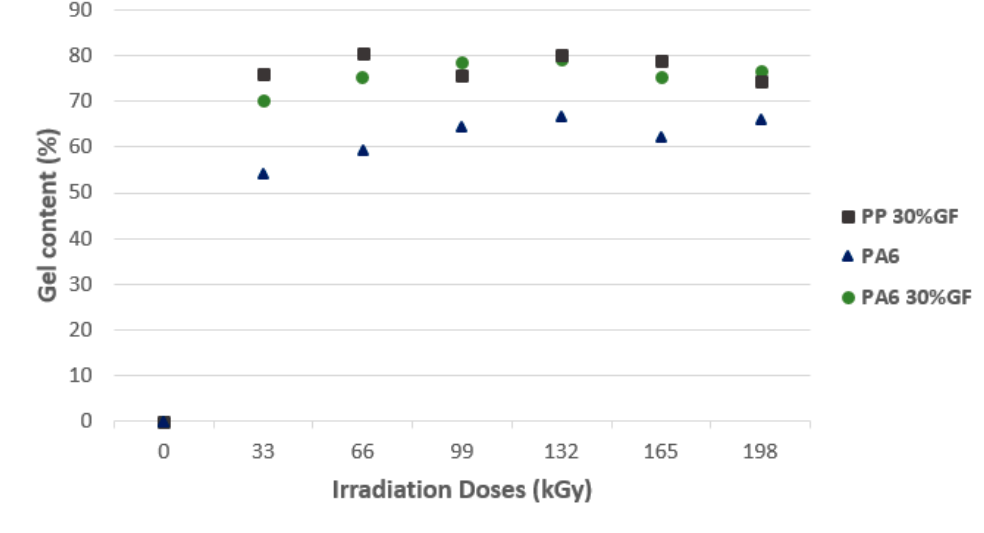
Figure 13. Gel content—Technical polymers.